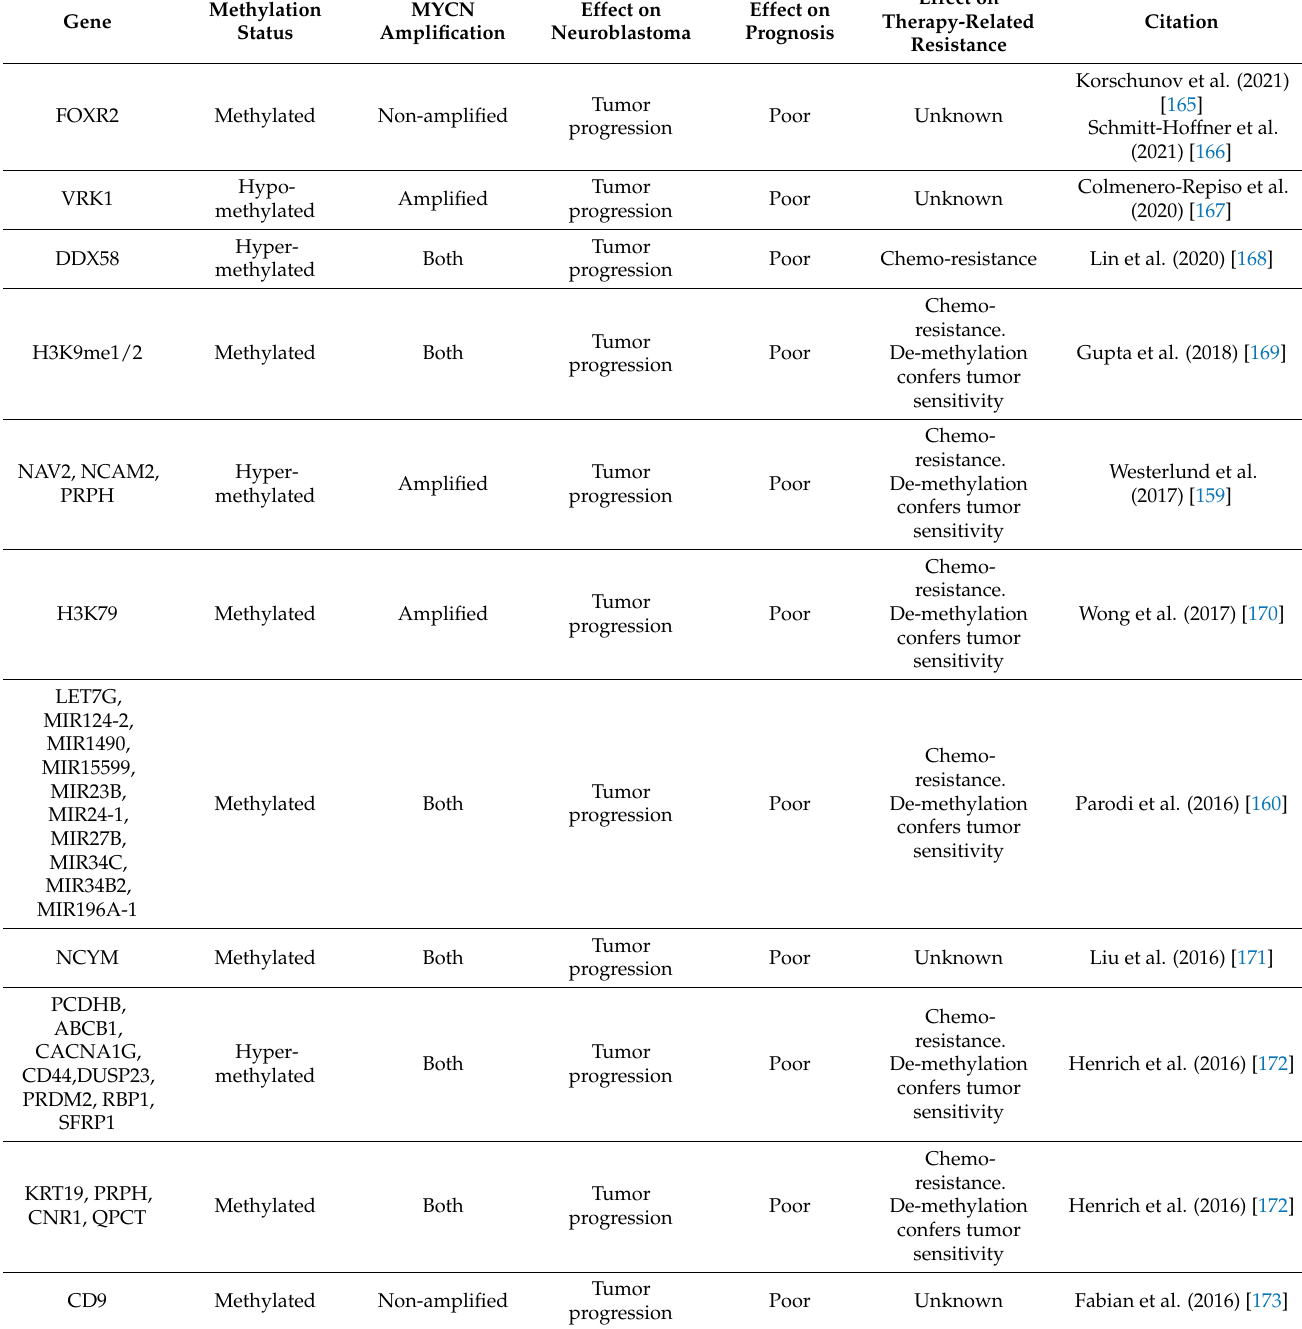
Table 4. MYCN -related methylation in